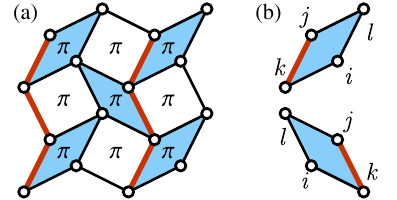
FIG. 10. (a) The π -flux model of fermionic spinons. The spinon hopping on the thick red bond gets a minus sign, such that each plaquette has a π flux. Additional spinon interaction terms are applied to blue shaded diamonds. (b) The arrangement of the site indices ½ ijkl (cid:4) around each shaded